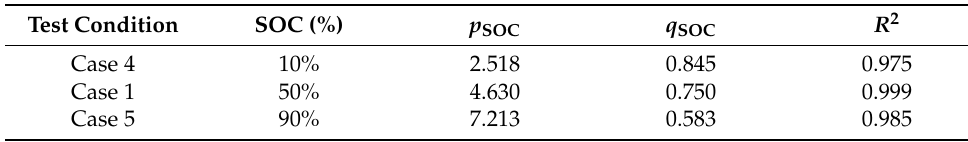
Table 6. The curve fitting coefficients of the resistance increase model considering SOC level variation (temperature is fixed to 55 ◦ C).